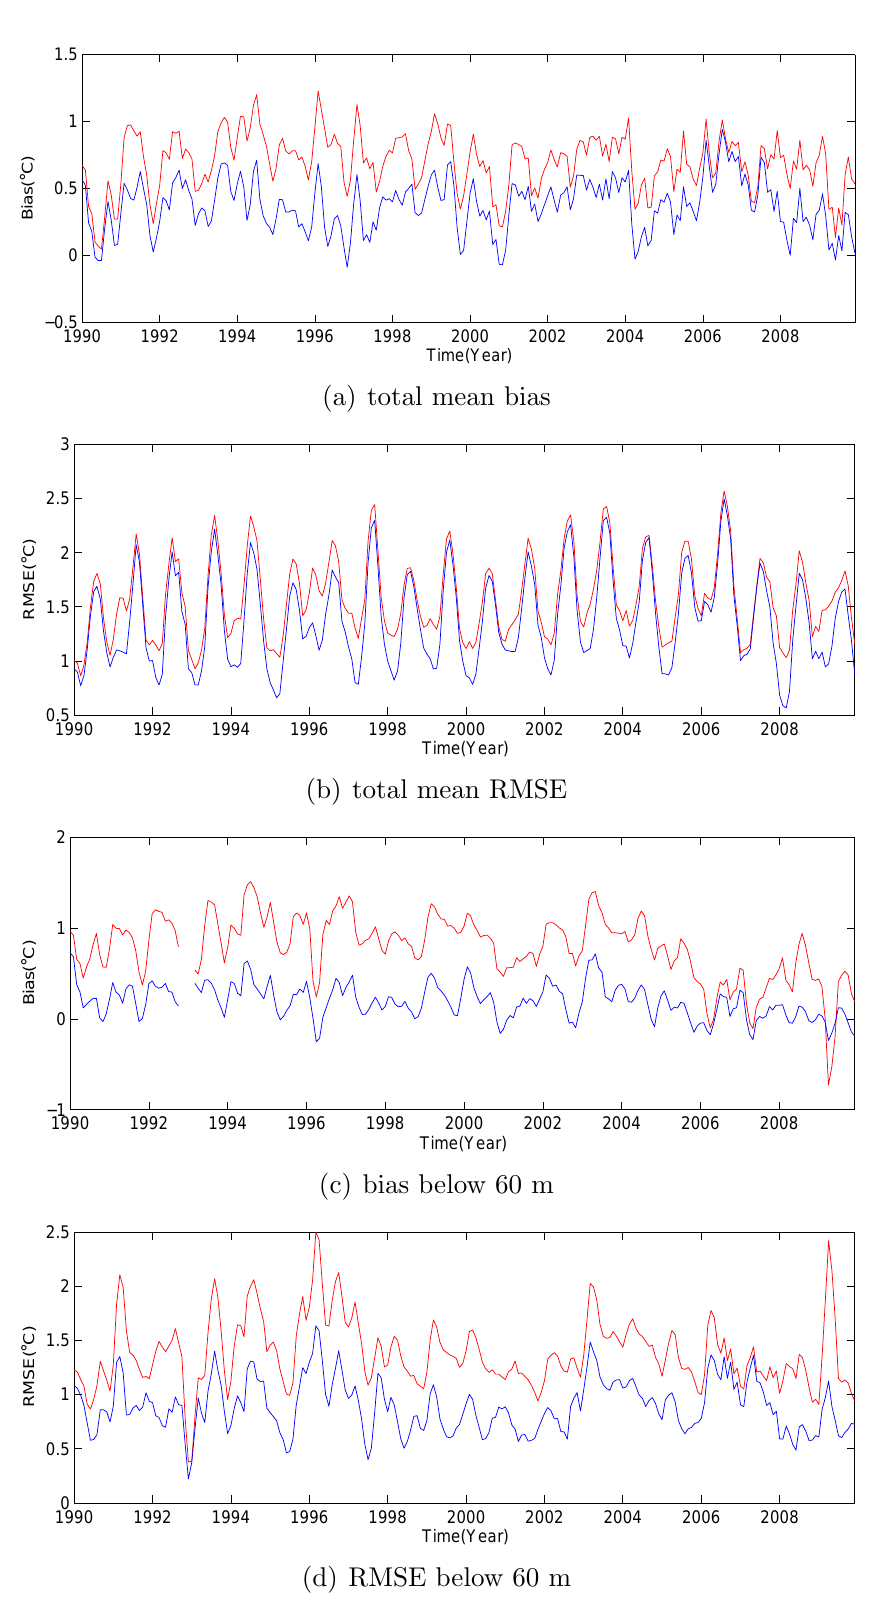
Fig. 6. The mean RMSE and bias of temperature caculated with monthly mean data from 1990 to 2009: (a) total mean bias, (b) total mean Figure 6: The mean RMSE and bias of temperature caculated with monthly RMSE, (c) mean bias below 60m, and (d) mean RMSE below 60m. The red is the free run and the blue is the mean data from 1990 to 2009: (a) total mean RMSE, (b) total mean bias, (c) mean RMSE below 60 m and (d) mean bias below 60 m. The red is the free run and the blue is the reanalysis.